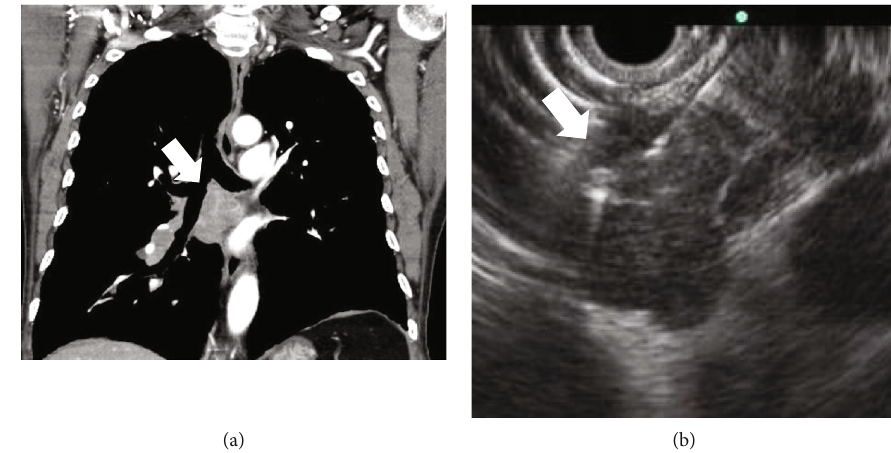
Figure 1: A 78-year-old male patient. (a) Subcarinal lymphadenopathy (arrow) is shown on CT scan. (b) On EUS view, multiple round shaped and sharp-demarcated lymph nodes (arrow) were conglomerated in station 7. The EUS-guided biopsy was performed. CT: computed tomography; EUS: endoscopic ultrasound.